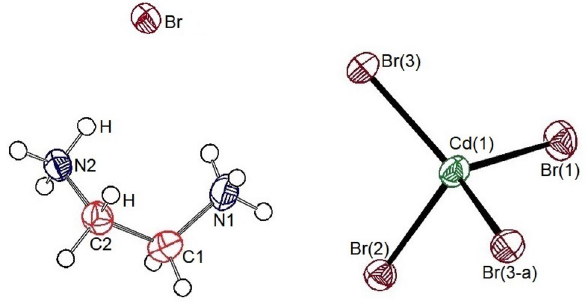
Figure 1. Thermal ellipsoid plot (50% probability) for [NH 3 (CH 2 ) 2 NH 3 ] 2 CdBr 4 ·2Br structure at 300 K.